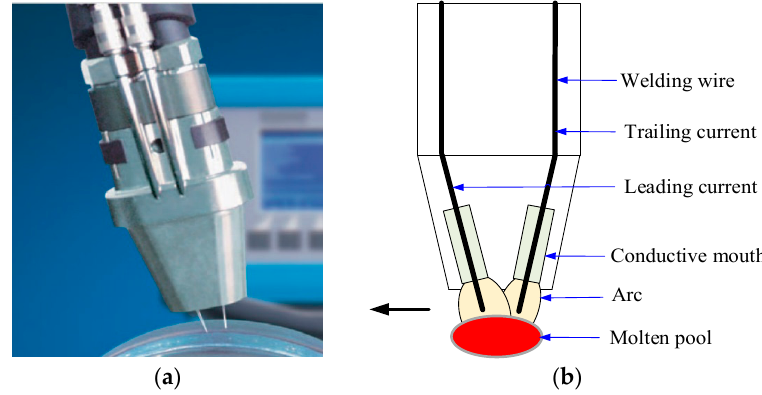
Figure 2. ( a ) Welding gun; and ( b ) welding pool of double-wire MIG arc welding.